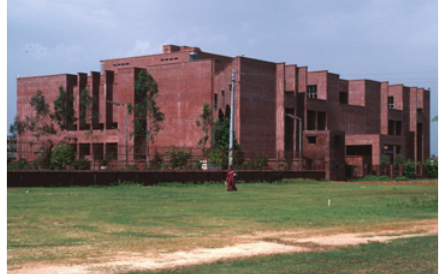
Figure 1. National Library of Bangladesh, Dhaka